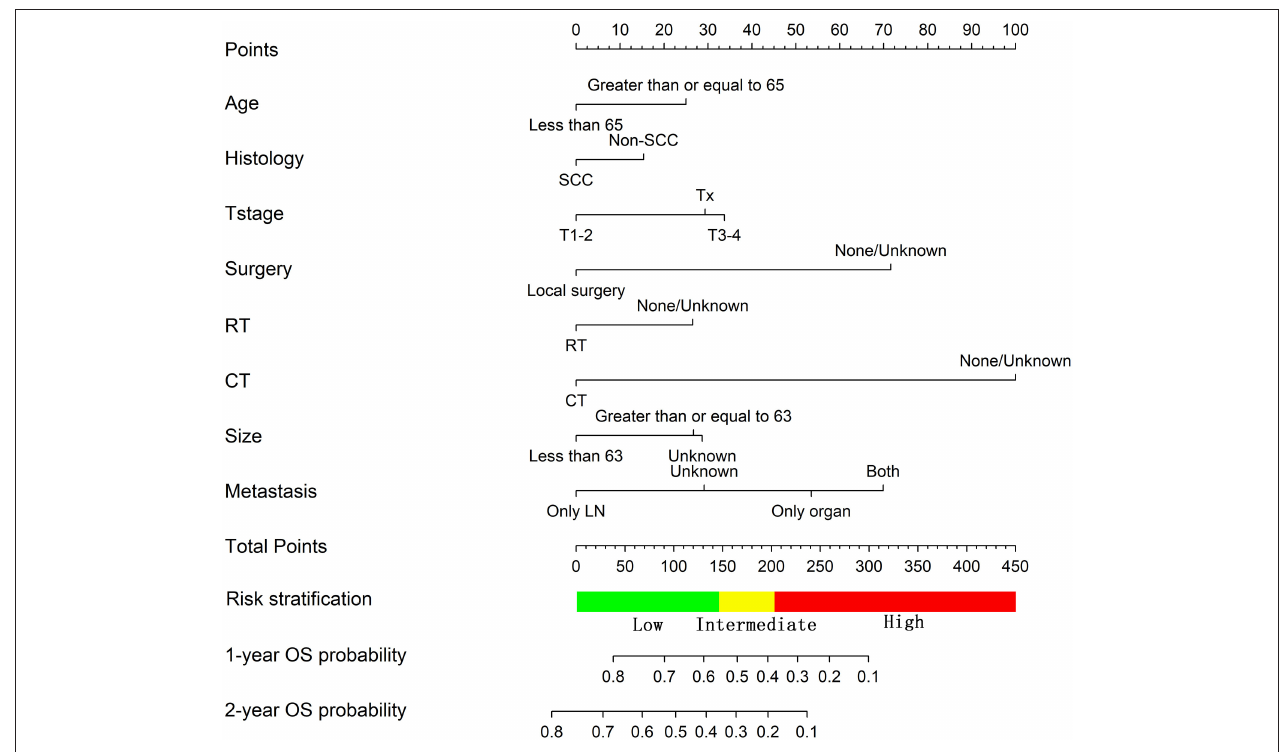
FIGURE 1 | Nomogram predicting the OS of patients with newly diagnosed, distant metastatic cervical carcinoma in the training